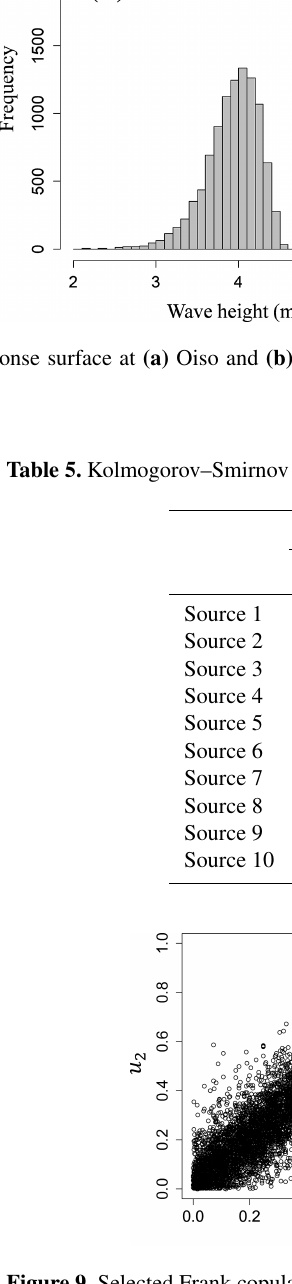
The rotated Gumbel copula corresponds to a copula that ro- tates the ordinary Gumbel copula by 180 ◦ . For reference pur- poses, the copulas for all earthquake sources are illustrated in Fig. 12. From the characteristics of the copula mentioned be- fore, there is a tail dependency in the wave heights due to source 1, 2, 3, 5, 7, and 9, but there is no tail dependency in the wave heights due to source 4, 6, 8, and 10. The tail de- pendency of the wave height could change in various